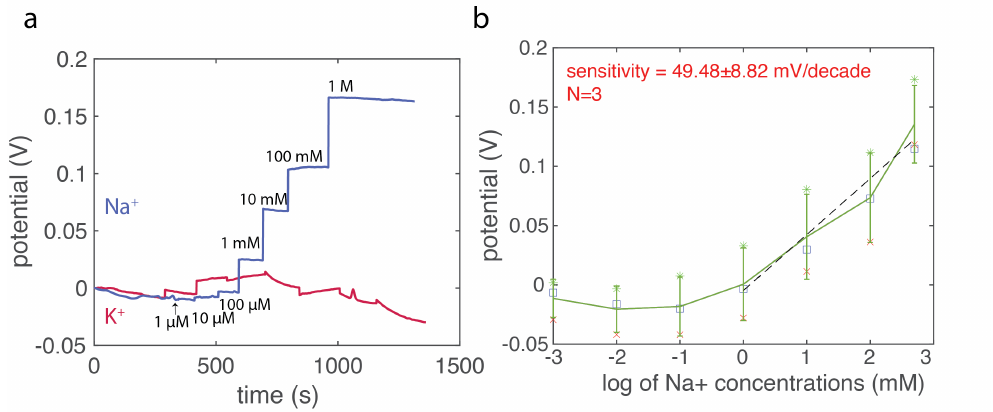
Figure 6. The Na + sensing characterization of the ion-sensitive membrane (ISM) functionlized CNT composite fibers. ( a ) The representative continuous measurement of the ISM-functionalized fibers to Na + ions (blue) and its selective response to the K + ions (red). ( b ) The sensitivity cal- culation of the Na + ion response across different devices (N = 3) with an average sensitivity of 49.48 ± 8.82 mV/decade. Different markers indicate individual devices with its